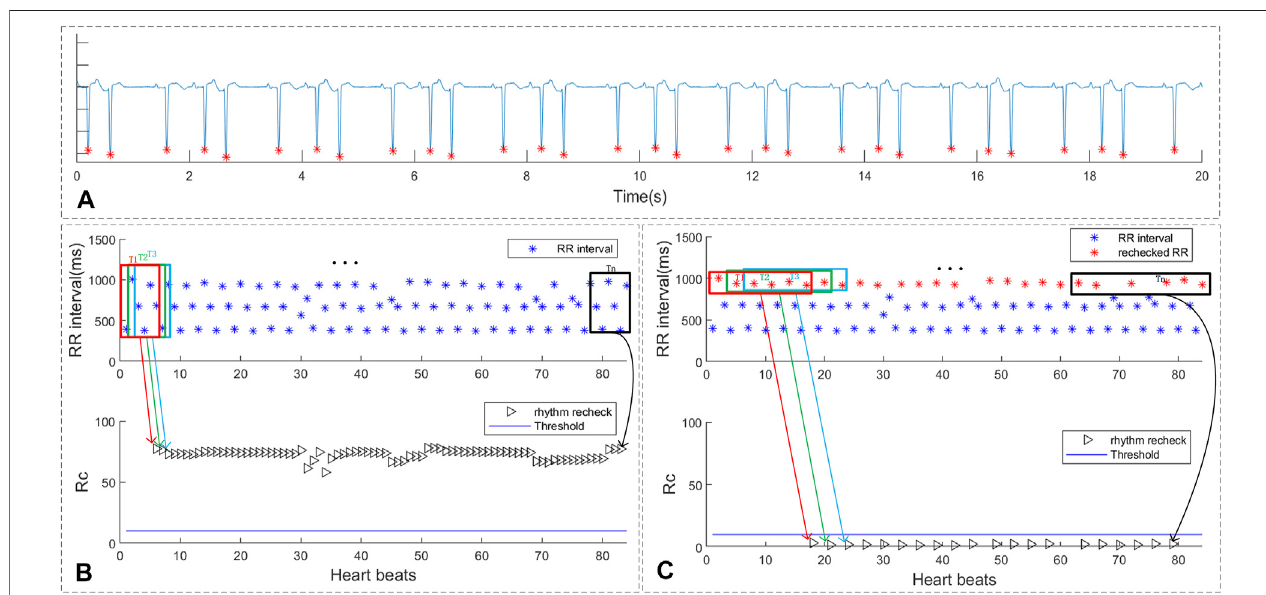
FIGURE8| TherhythmrecheckresultofECGwithtrigeminyPVC. (A) ECGsegmentwithtrigeminyPVC; (B) RRintervalsandsuspicioussegmentscreeningresult. (C) the rechecked RR intervals and suspicious segment screening result